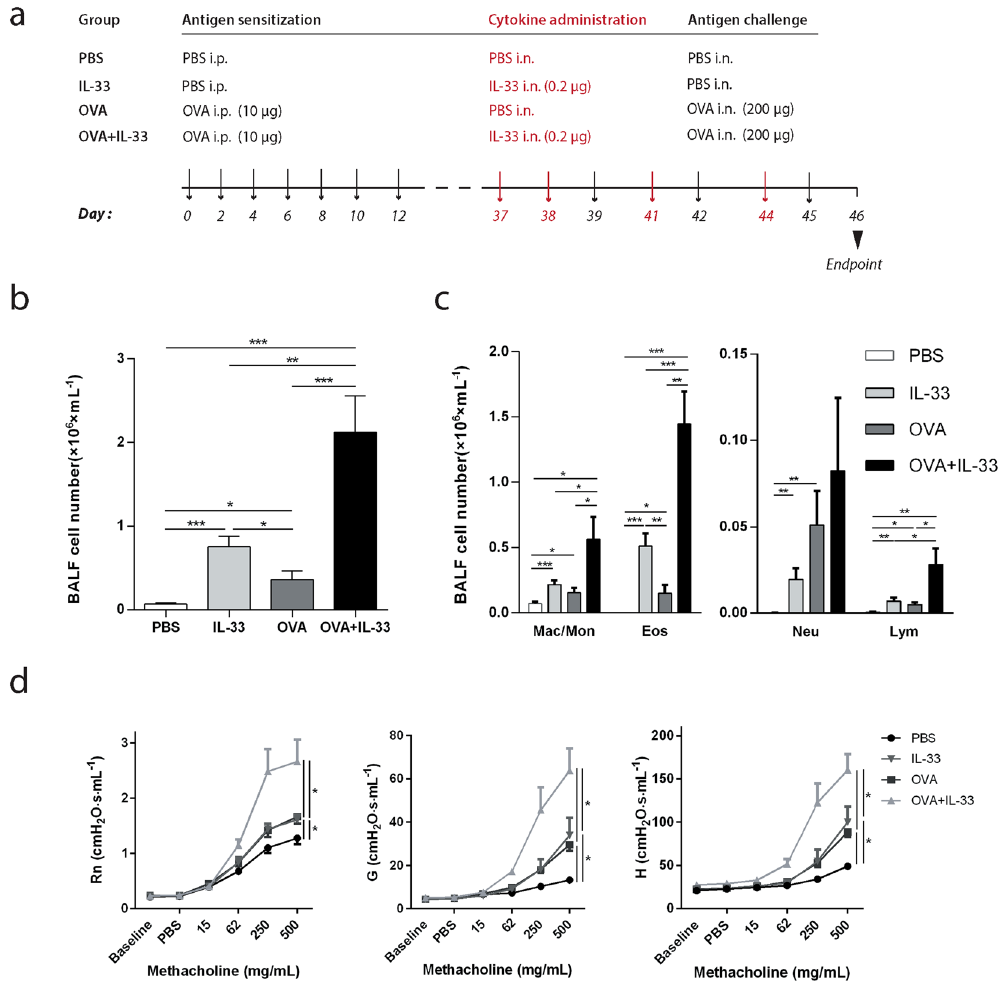
Figure 1. IL-33 potentiates antigen induced inflammation in BALF and airway hyperresponsiveness. ( a ) Schematic representation of the exposure protocol. Sham-or OVA-sensitized C57BL/6 mice received intranasal instillations of IL-33 or PBS. ( b ) Total inflammatory cells in BALF were counted. ( c ) Differential cell counts in BALF were determined. Results expressed as cells/mL for macrophages/monocytes, eosinophils, neutrophils and lymphocytes. ( d ) Airway hyperresponsiveness (AHR) in response to inhaled methacholine was measured in sham- or OVA-sensitized C57BL/6 mice that received intranasal instillations of IL-33 or PBS. Maximal responses to increasing doses of methacholine are shown for newtonian resistance ( Rn ), tissue damping ( G ) and tissue elastance ( H ) ( b – d ) * p < 0.05, ** p < 0.01, *** p < 0.001 (ANOVA, Bonferroni). Results are pooled data from four independent experiments (mean ± SEM of n = 9–10 mice for each